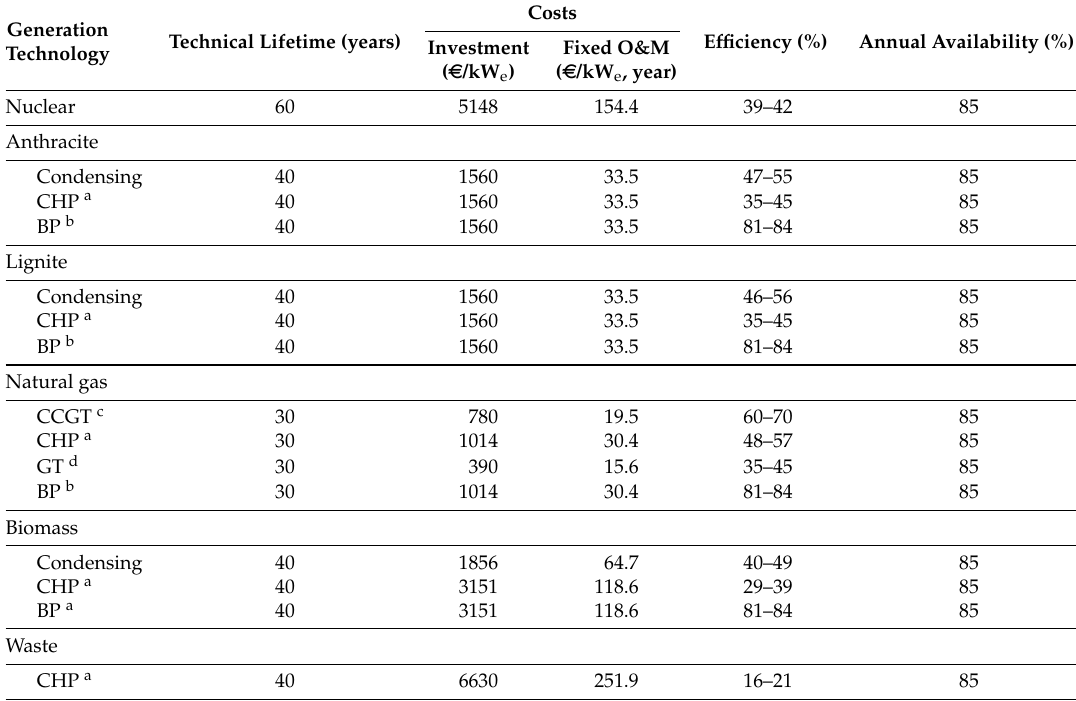
Table A1. Base input data and assumptions for new thermal electricity generation technologies available for investment in the ELIN model. Investment costs come from [22]. Assumptions regarding lifetimes are based on